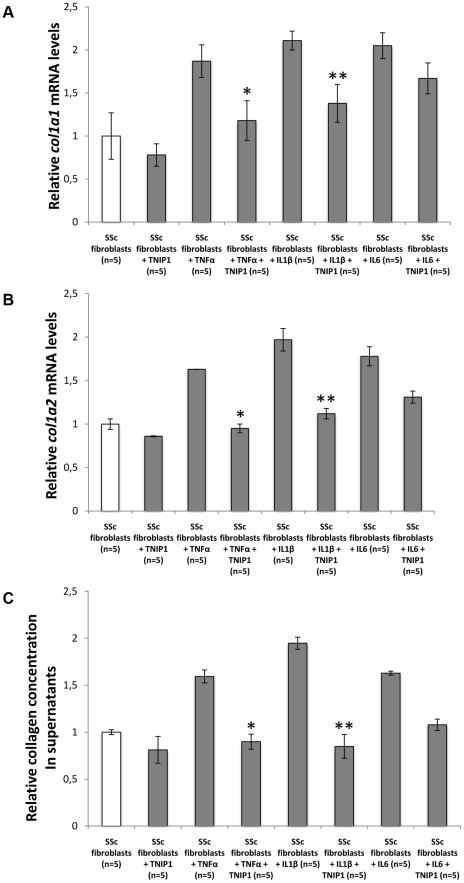
TNIP1 abrogates the profibrotic effects of proinflammatory cytokines on collagen synthesis by SSc fibroblatsts.(A,B) SSc dermal fibroblasts treated with recombinant TNFa or IL1β and incubated 24 hours with TNIP1 displayed decreased mRNA levels for (A) COL1A1 (1.6 and 1.5-fold reduction, P = 0.02 and 0.04, respectively) and (B) COL1A2 (1.7 and 1.8-fold reduction, P = 0.02 and 0.009, respectively). No significant effect was observed in cells treated with recombinant IL6. (C) Collagen content in cell culture supernatants treated with TNFa or IL1β was also reduced upon treatment with TNIP1 (1.8 and 2.3-fold reduction, P = 0.04 and 0.03, respectively). * indicates a P<0.05 vs. SSc fibroblasts treated with recombinant TNFa. ** indicates a P<0.05 vs. SSc fibroblasts treated with recombinant IL1 β.